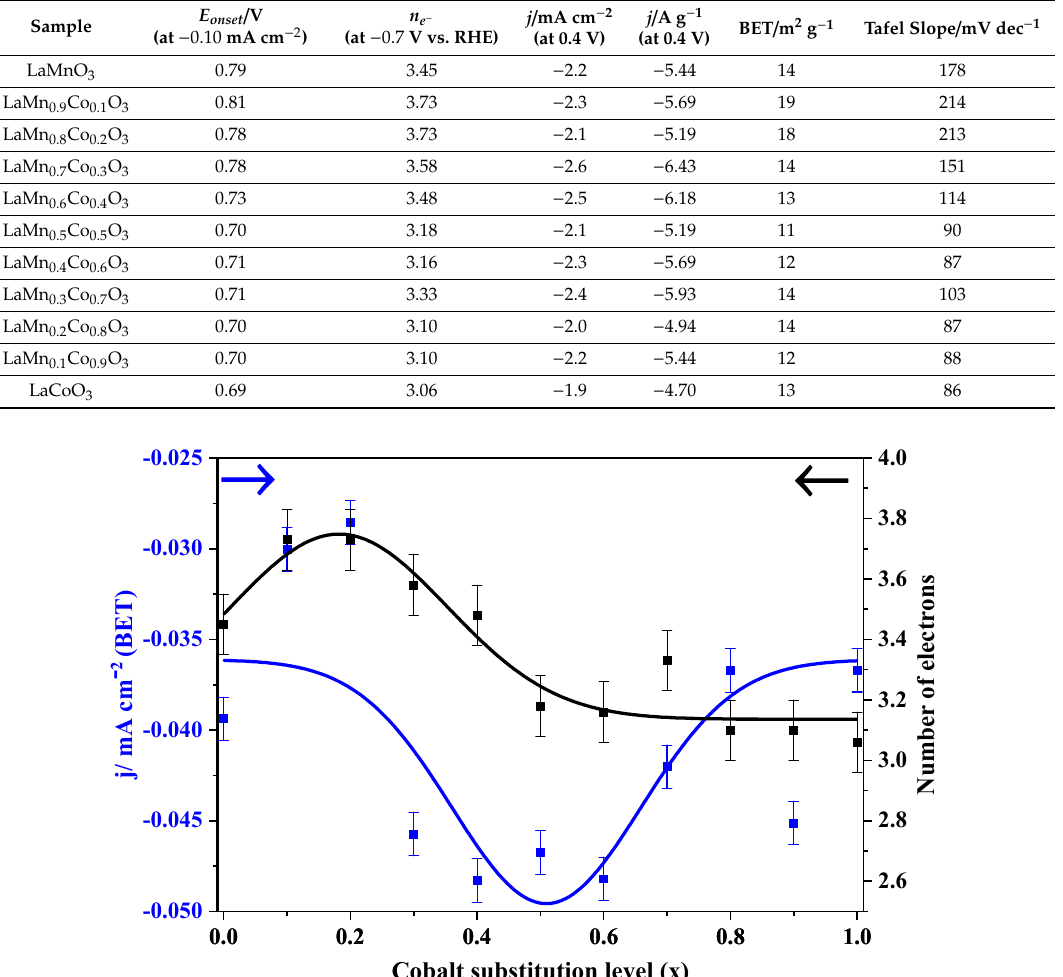
Figure 3. Change in BET-normalized current density and number of the electrons with increasing cobalt content in LaMn 1 − x Co x O 3 perovskite materials—data obtained at 0.4 and 0.7 V, respectively.